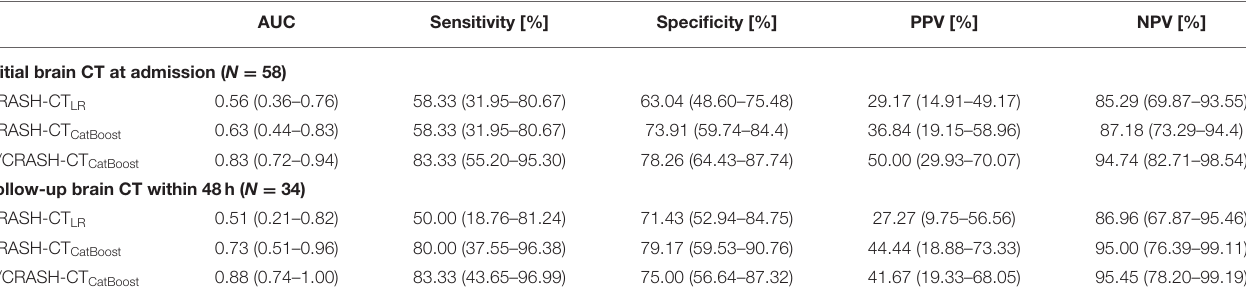
TABLE 3 | Comparison of prognostic models for predicting outcome favorability based on the initial and follow-up CT-based LOOCV. AUC Sensitivity